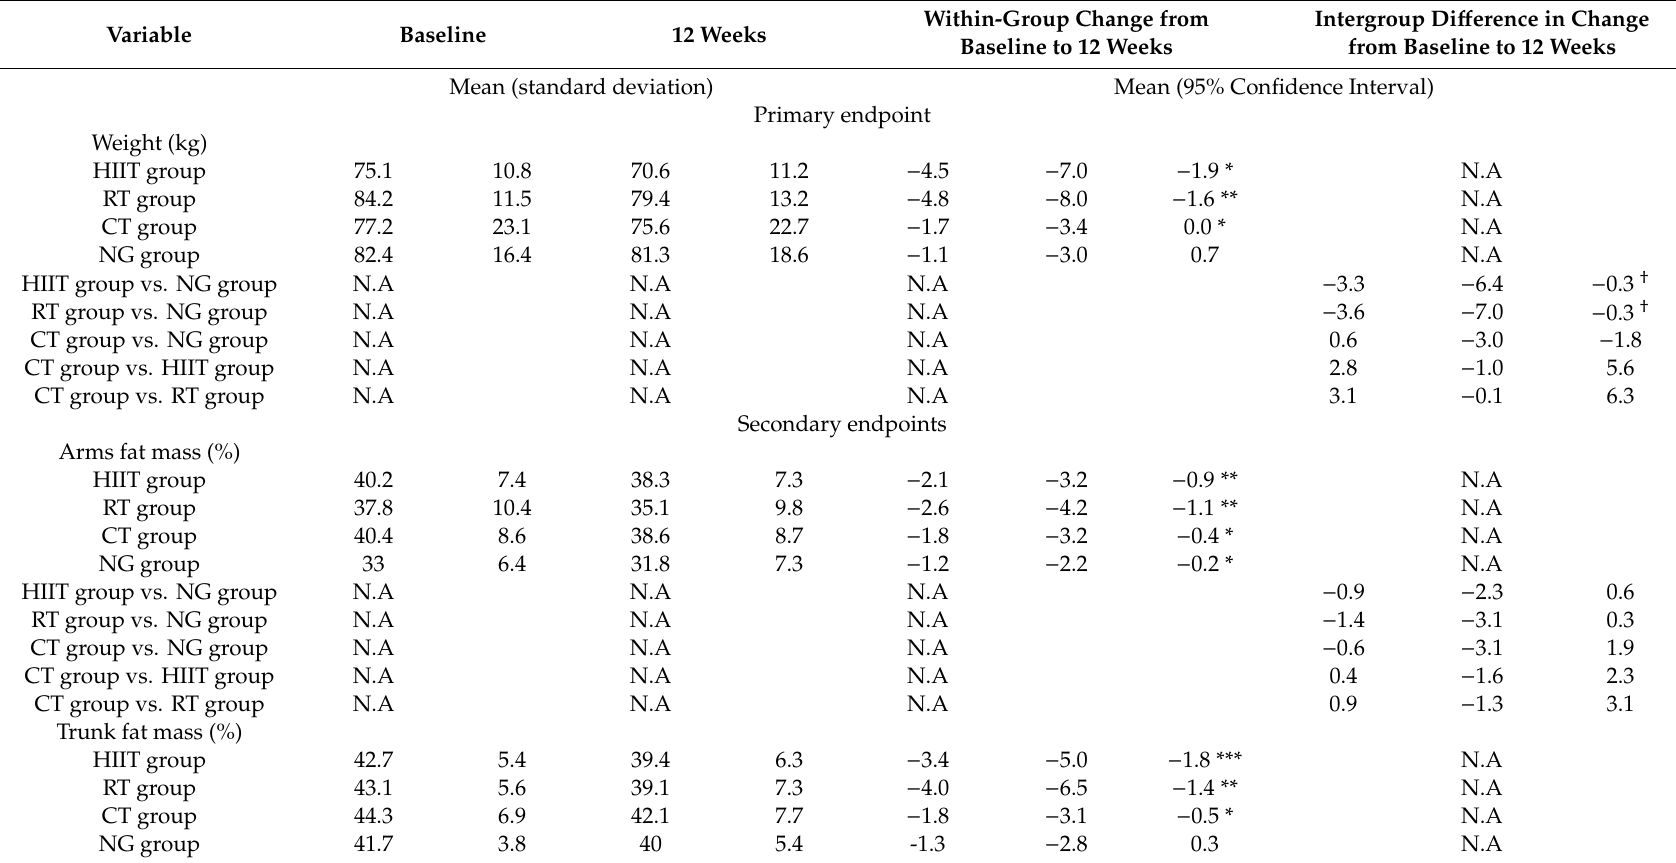
Table 2. Anthropometrics, body composition (fatness / lean mass) and distribution indices at baseline, and changes after 12 weeks by